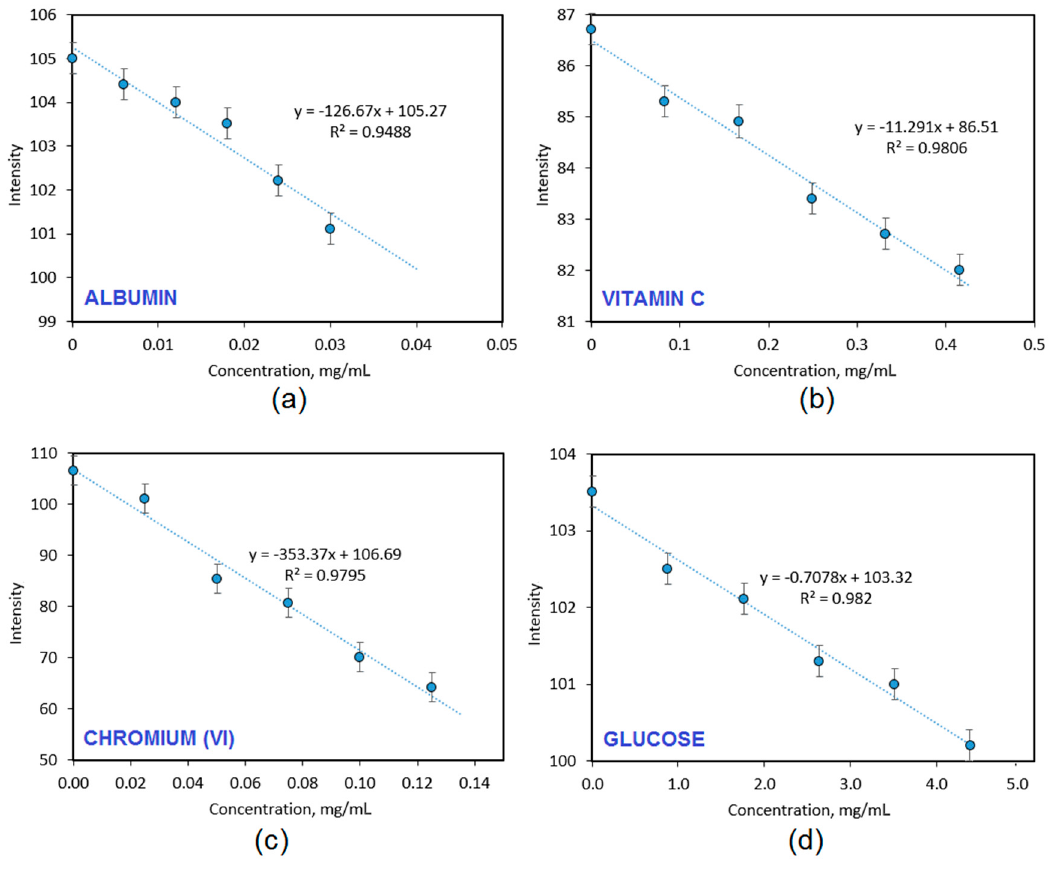
Figure 10. The study on biodetection abilities carried out in PBS of the CQDs-2 sample: ( a )—detection of the albumin; ( b )—detection of the vitamin C; ( c )—detection of the chromium (VI) ions and ( d )—detection of the glucose.